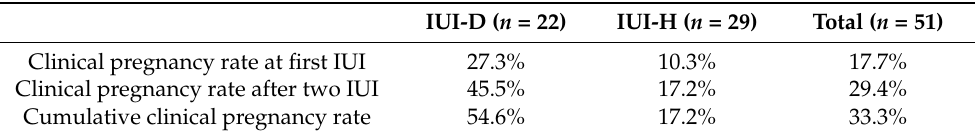
Table 4. Clinical outcomes after tubal patency